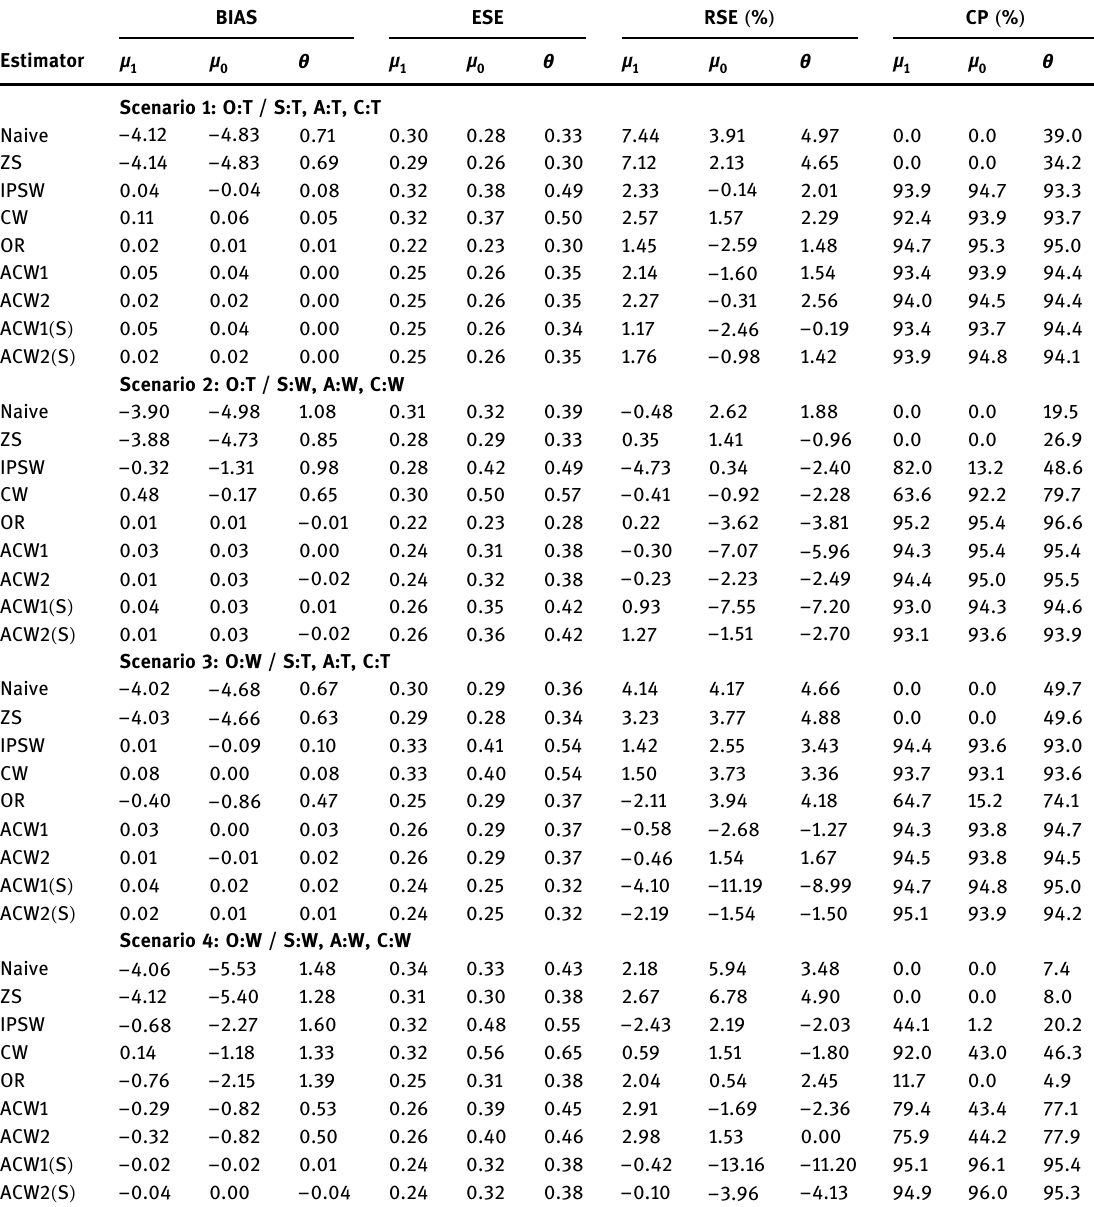
Table 2: Simulation results under four scenarios; T: true ( correct ) model, W: wrong ( incorrect ) model. Bias is the empirical bias of point estimates; ESE is the empirical standard error of estimates; RSE is the relative bias ( % ) of bootstrap standard error estimates; CP is the empirical coverage probability of the 95% con fi dence intervals BIAS ESE RSE ( % ) CP ( % ) Estimator